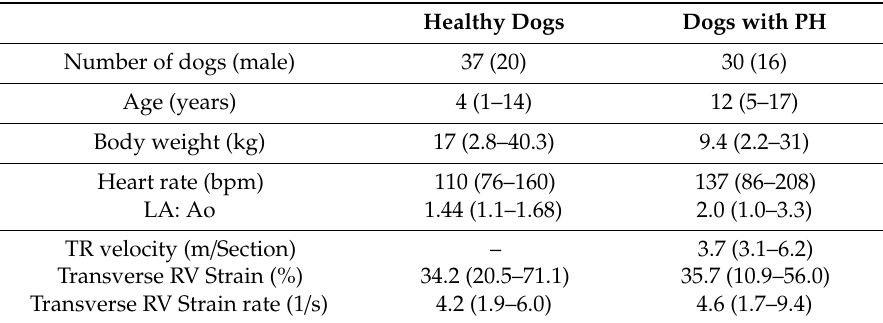
Table 1. Clinical and echocardiographic data for 67 dogs included in the